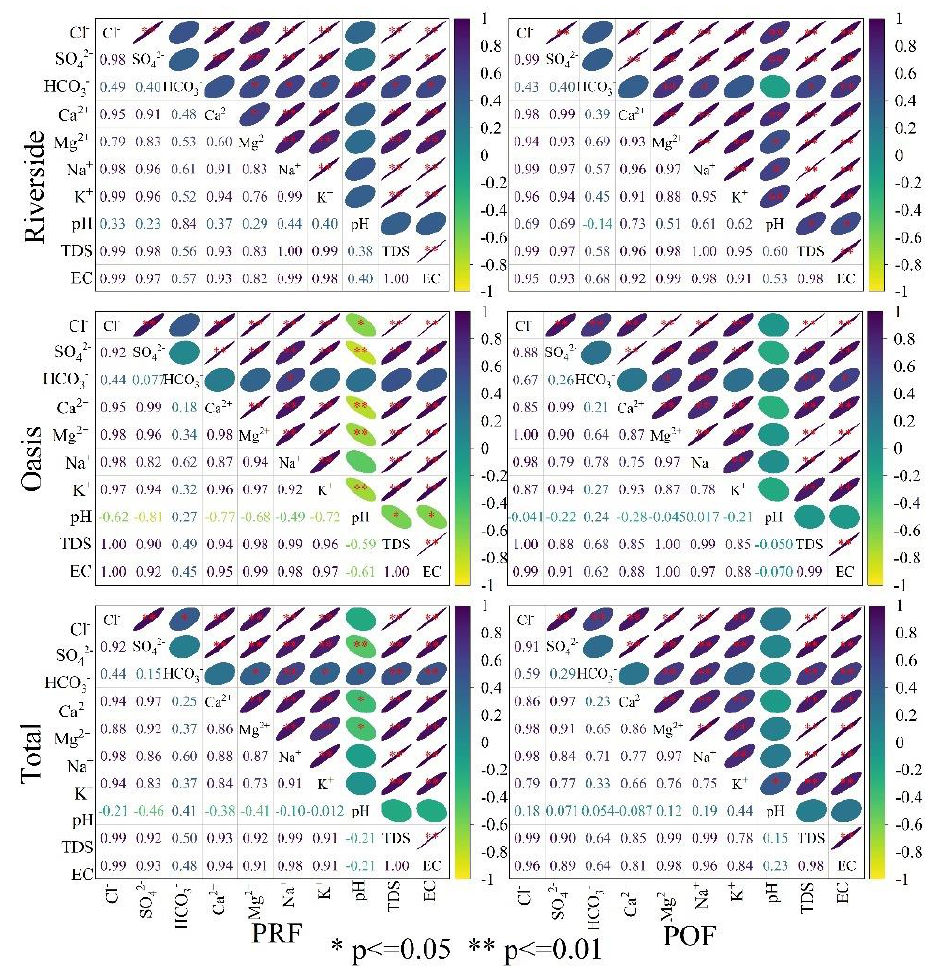
Figure 2. Results of Pearson correlation analysis.